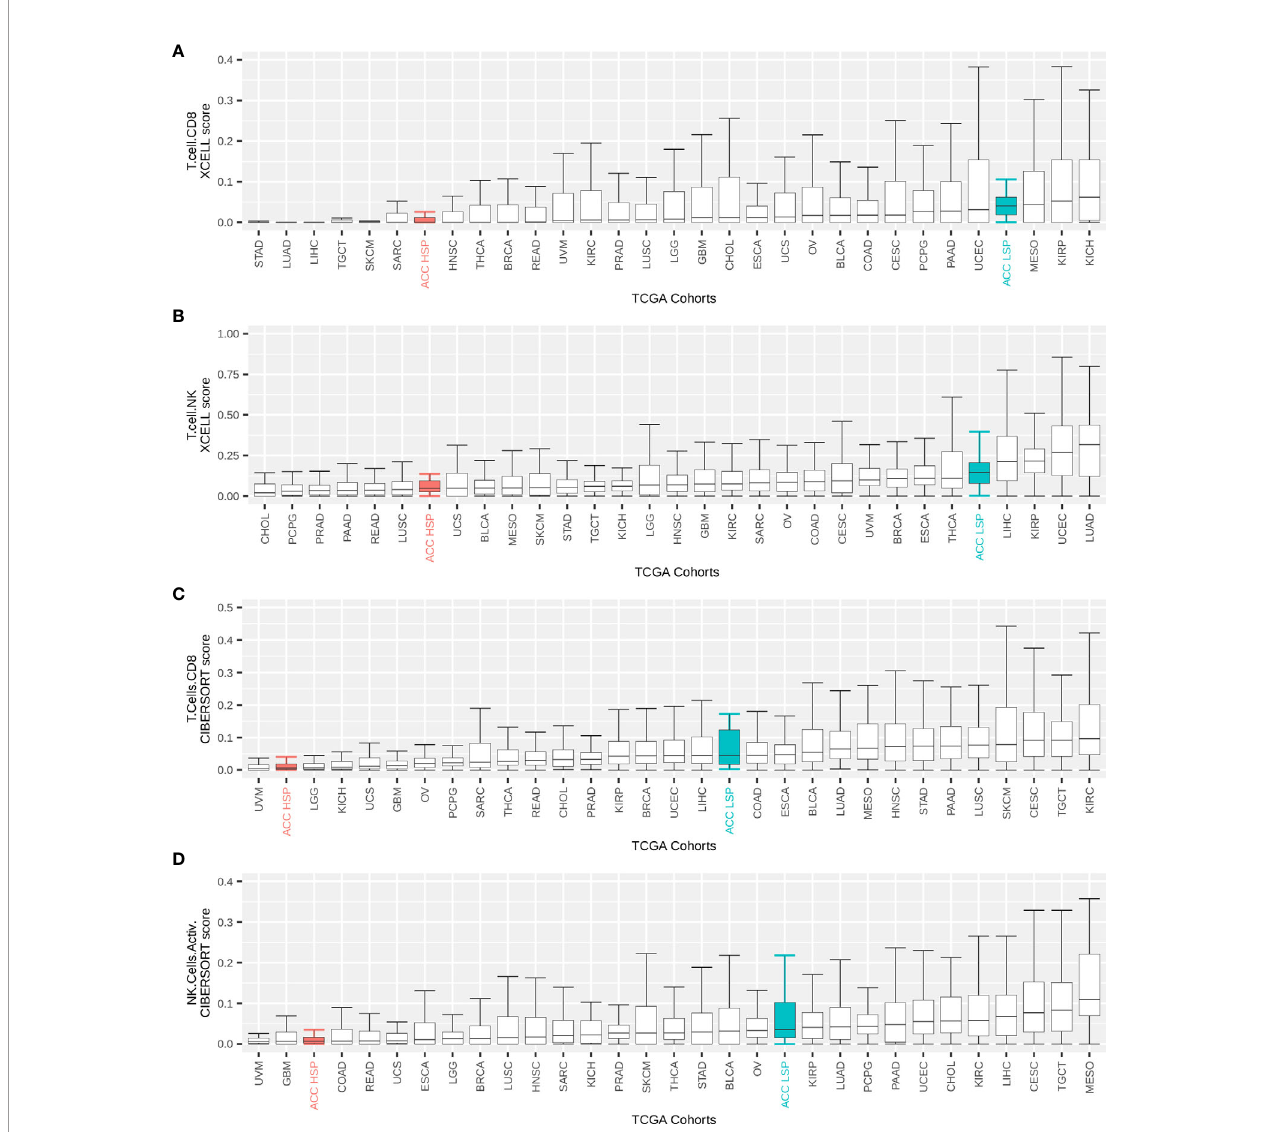
FIGURE 2 | TCGA pan-cancer comparison of immune in fi ltrates. Immune in fi ltrate scores (y-axis) were rescaled to range from 0 to 1. The maximum on the y-axis is independently set for each plot for better visualization. Participants were grouped by TCGA cohort and the boxplot shows median and IQR for immune cell in fi ltrate scores of each cohort. Whiskers are set at 1.5 IQR and outliers (above and below the 1.5 IQR) are not shown. TCGA cohorts were ordered by median values. Patients with ACC were divided according to steroid phenotypes (A, B) xCell scores for CD8+ T cells and T natural killer (NK) cells inferred by Sturm et al. (39). (C, D) Cibersort scores for activated CD8+ T cells and NK cells as inferred by Thorsson et al. (11) and multiplied by the leukocyte fraction as described by these